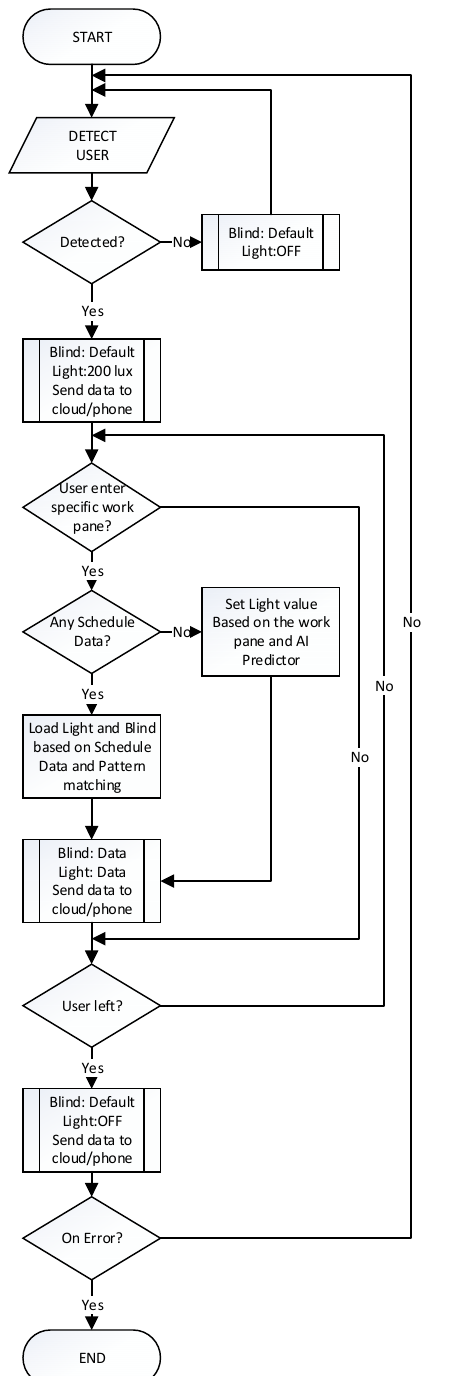
Figure 2. The proposed system flowchart.